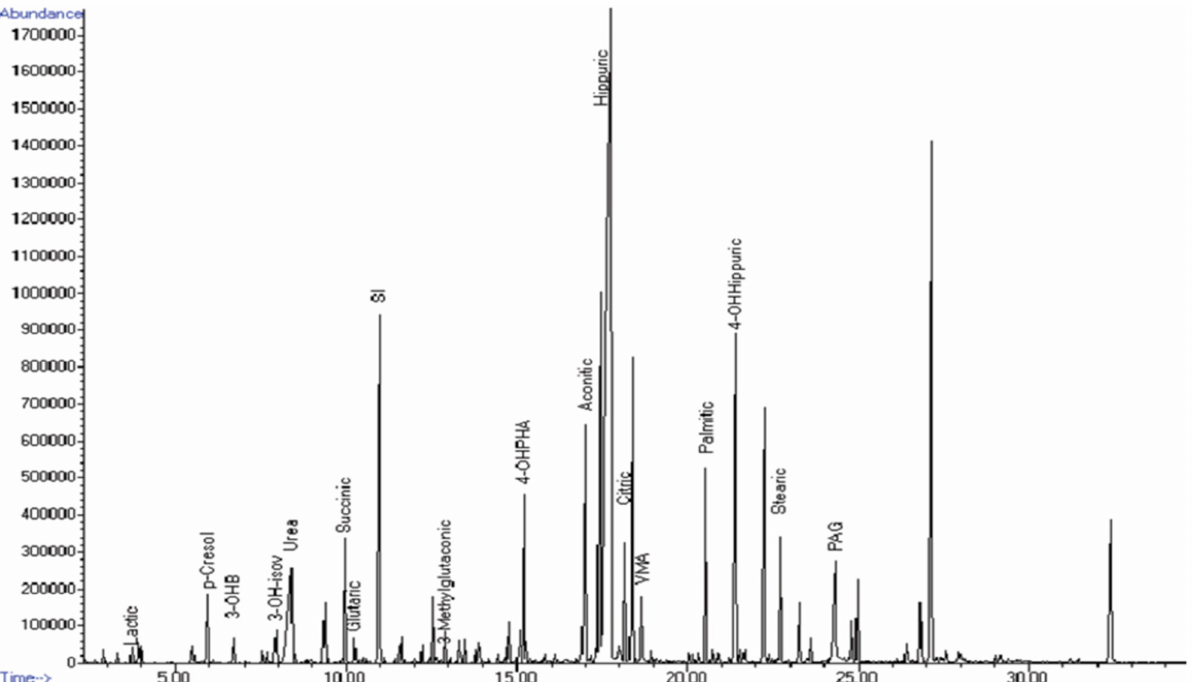
Figure 2. GC–MS profile chromatogram from healthy individuals. Peaks detected for lactic acid, p-cresol, 3- hydroxybutyric acid (3-OHB), 3-hydroxyisovaleric acid (3-OH-isov), urea, succinic acid, glutaric acid, internal standard (SI), 3-methylglutaconic acid, 4-hydroxyphenylacetic acid (4-OHPHA), aconitic acid, hippuric acid, citric acid, vanillylmandelic acid (VMA), palmitic acid, 4-hydroxy-hippuric acid, stearic acid, and phenylacetyl glutamine